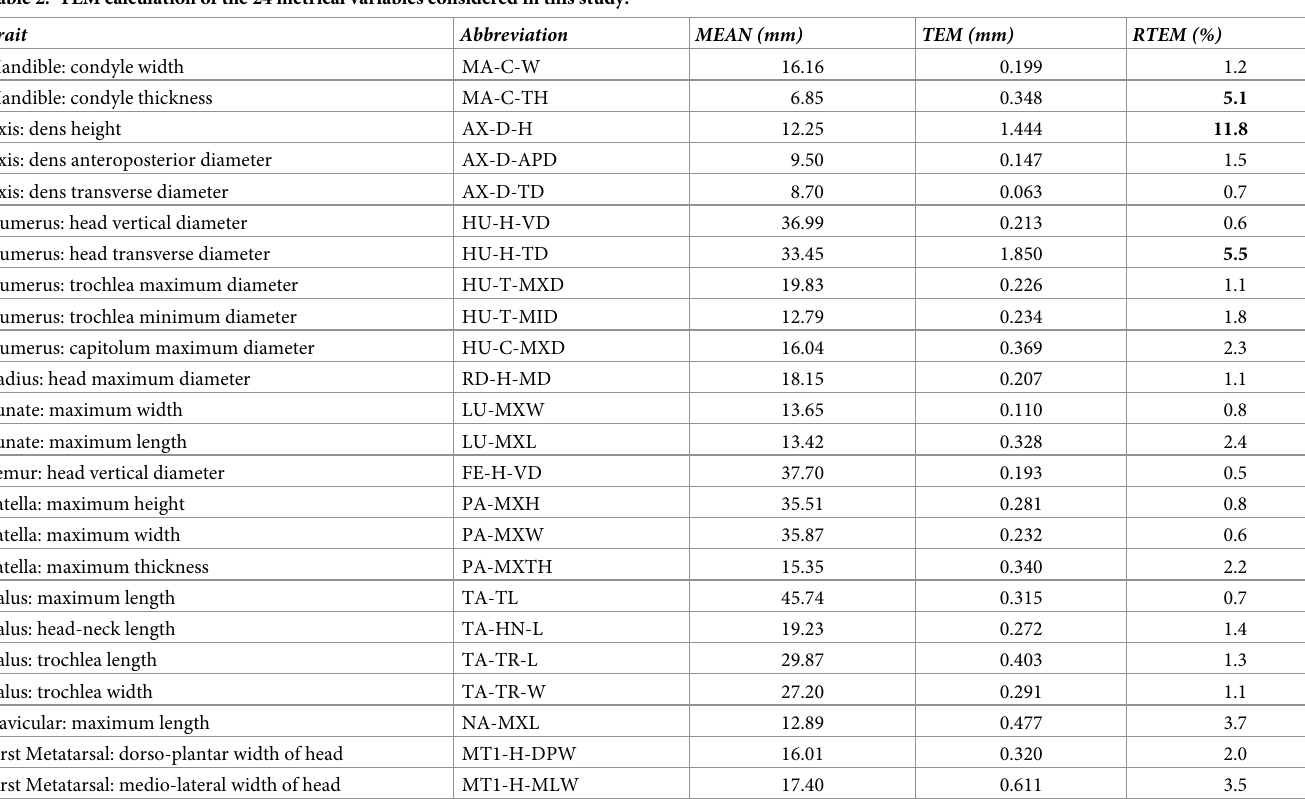
Table 2. TEM calculation of the 24 metrical variables considered in this